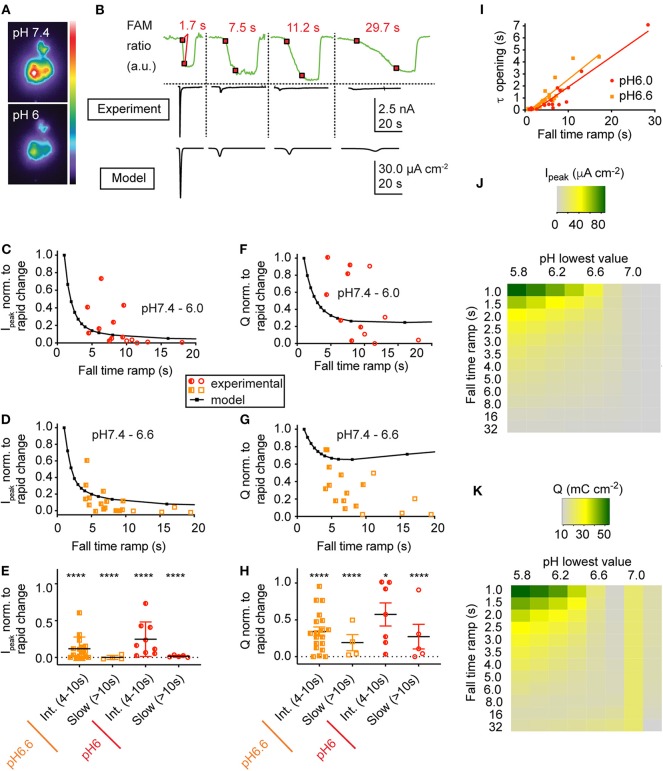
Slowing of the pH change reduces the current amplitude and the transported charge. (A) Pseudocolor image by the pH-sensitive fluorescent dye 5(6)-FAM of the same cell at pH 7.4 and at pH 6.0. (B) Fluorescence intensities (green traces, upper panel) as a function of time in response to pH ramps of different speed from pH 7.4 to pH 6.0. The 10–90% fall-time (FT) of the fluorescence change corresponds to the interval between the two red squares (Materials and Methods). Each fluorescence trace (top panel) was measured simultaneously with the corresponding ASIC1a current trace (middle panel). Bottom panel, traces created by the kinetic model in response to the above pH ramps. The experimental data in (B–I) are from whole-cell patch-clamp at −60 mV. (B–H) Current and transported charge values are normalized to the corresponding response measured in the same cell to a rapid pH change (ramp FT < 4 s). (C,D) ASIC1a peak current amplitudes in response to pH 7.4–6.0 ramps (C) or pH 7.4–6.6 ramps (D) of different duration, shown as function of pH ramp FT (n = 14–20). The model prediction is indicated with black symbols and the connecting line. (E) Normalized peak current amplitudes for ramp durations classified into intermediate (ramp FT 4–10 s) and slow (ramp FT > 10 s; n = 4–16). ****p < 0.0001, different from rapid change (ANOVA, Tukey post-hoc test). (F,G) Transported charge (Q), the current integral over time, is indicated for the same protocols as shown in (C,D) (n = 12–17). The model prediction is indicated with black symbols and the connecting line. (H) Normalized transported charge for ramp durations classified as in E (n = 4–16). *p < 0.05; ****p < 0.0001, different from rapid change (ANOVA, Tukey post-hoc test). (I) Time constant of ASIC current appearance in pH 7.4–6.0 (red symbols) and pH 7.4–6.6 ramps (orange), plotted as a function of the pH ramp FT. The r2 values were 0.906 (p < 0.001, pH 7.4–6.0 ramps) and 0.846 (p < 0.001, pH 7.4–6.0 ramps), n = 21–29. (J,K) Heat map of the simulated peak ASIC1a current (J) or charge transport (K) as a function of the pH ramp lowest value (pH) and duration (FT) in seconds. Shown are the amplitude of the maximal current (Ipeak, μA cm−2) and the transported charge (Q, mC cm−2) according to the scaling bar.